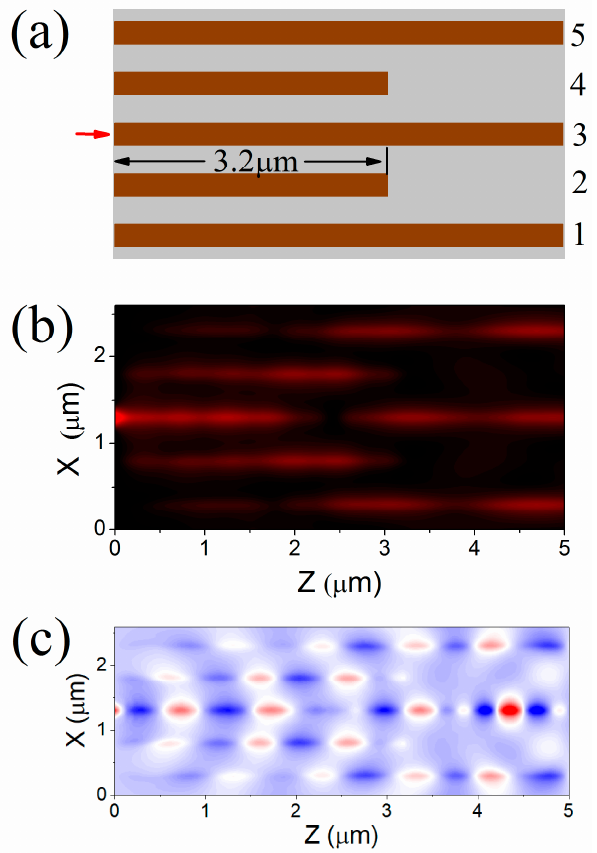
Figure 5. ( a ) Schemes of 1 × 3 power splitter based on five HPWs. ( b ) The intensity distribution of SPPs in the power splitter. ( c ) The field distribution of SPPs in the power splitter.